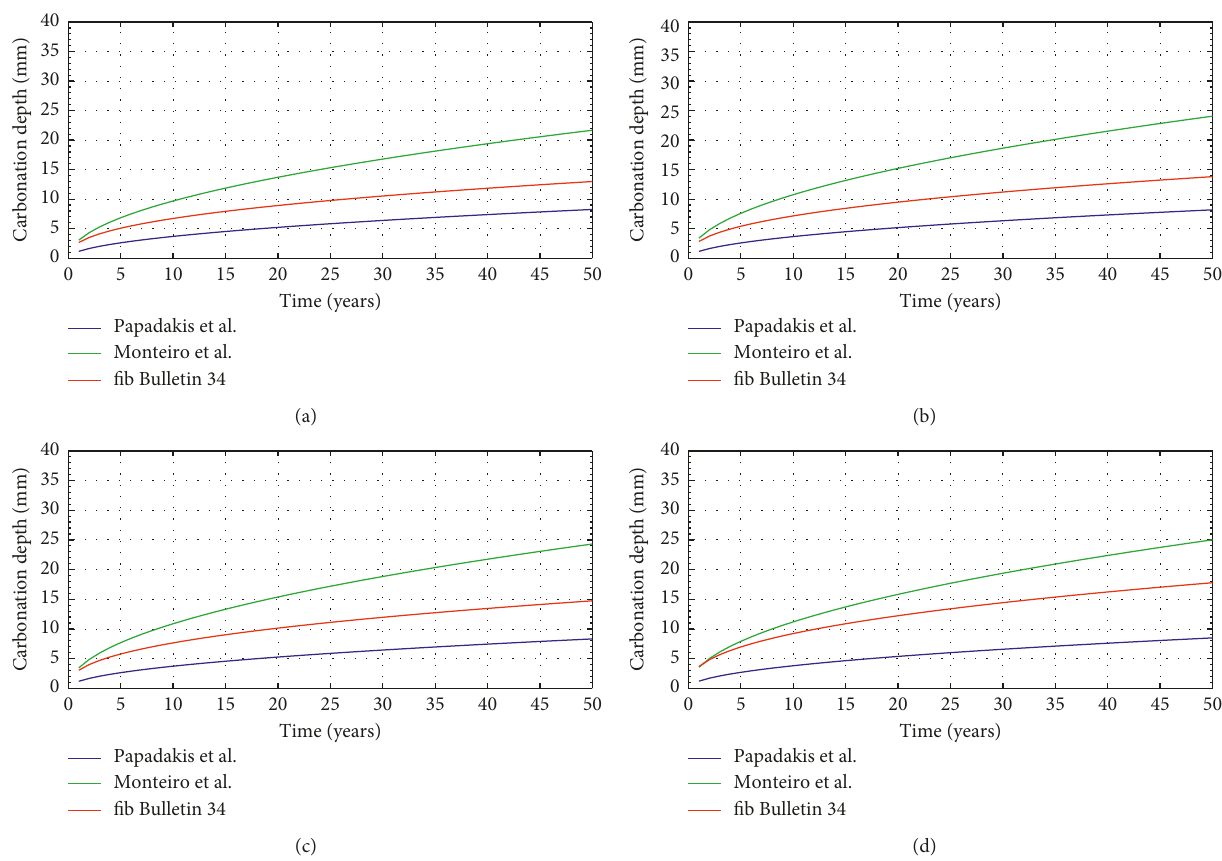
Figure 8: Comparison between models’ prediction of carbonation depth versus service life: XC4 exposure class: w/c � 0.50. (a) R � 0%; (b) R � 20%; (c) R � 50%; (d) R �